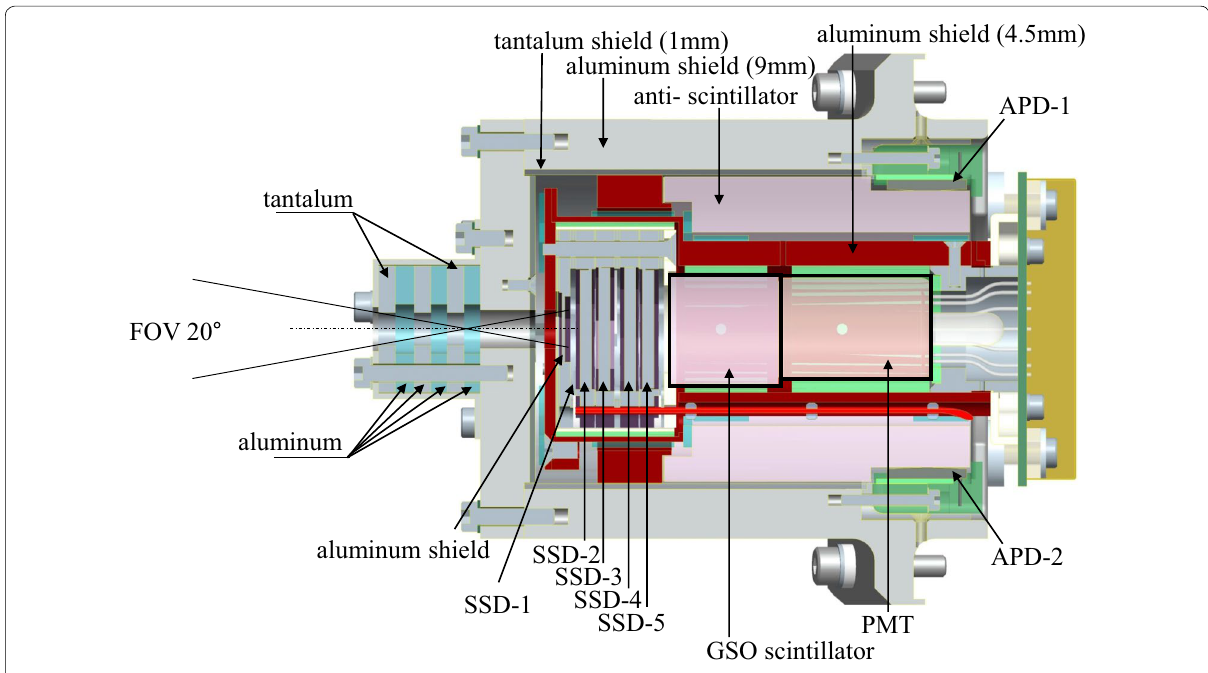
Fig. 2 A cross-sectional view of the XEP’s detection unit (flight